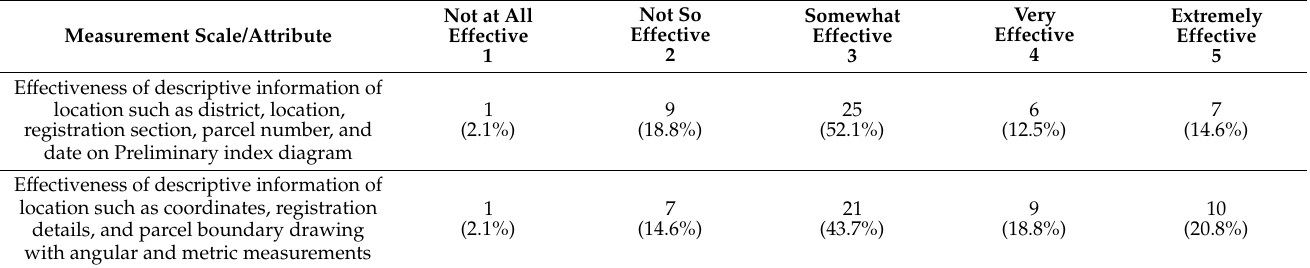
Table 4. Focussed Group discussion result on the effectiveness of LAS of Kenya ( n = 48).